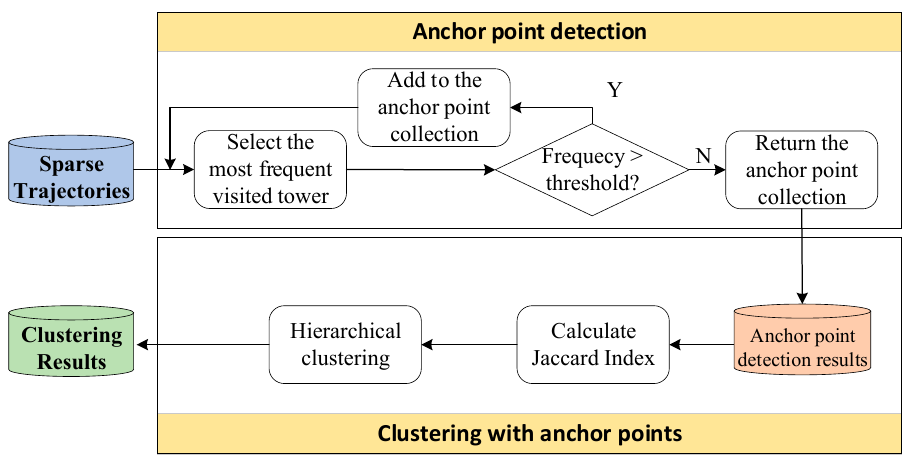
Figure 3. Flowchart of the anchor-point-based clustering method.